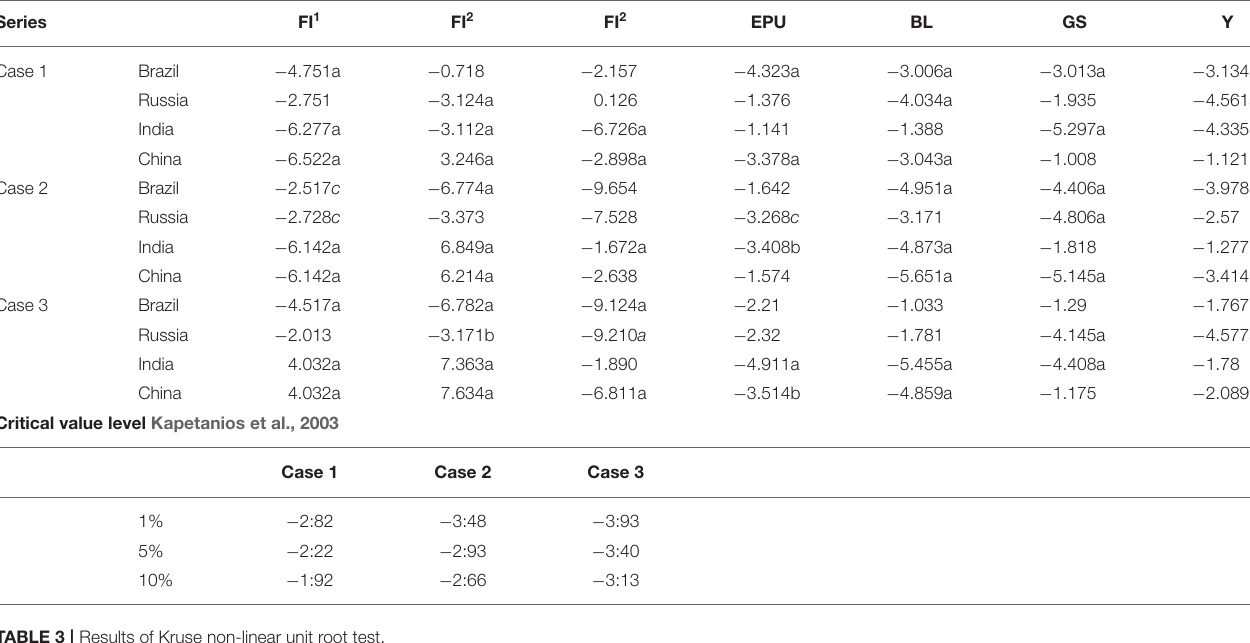
TABLE 2 | Results of KSS non-linear unit root test.